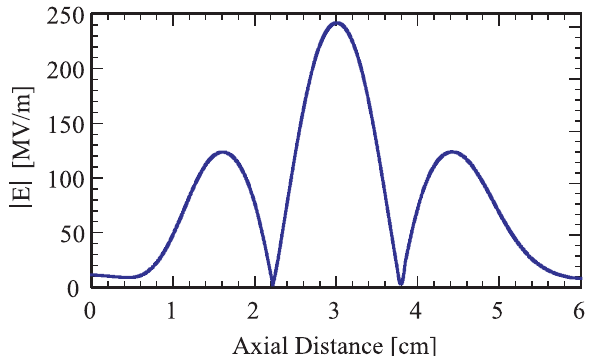
FIG. 6. Electric field relative magnitude on axis of PBG struc- ture. Power is coupled in from the left; half field is seen in each coupling cell, relative to the central PBG